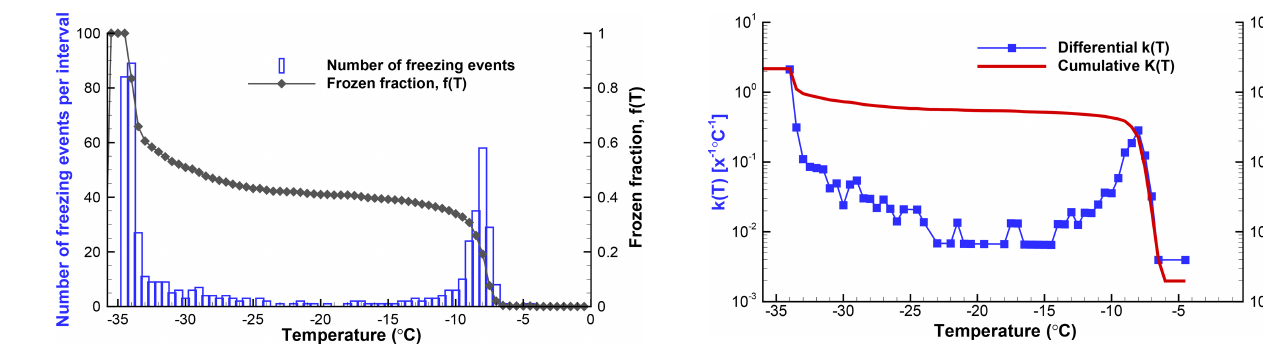
Figure 3. Histogram of freezing temperatures and a plot of the frac- tion of drops frozen for the data from Table 1 (Snomax TM suspen- sion).